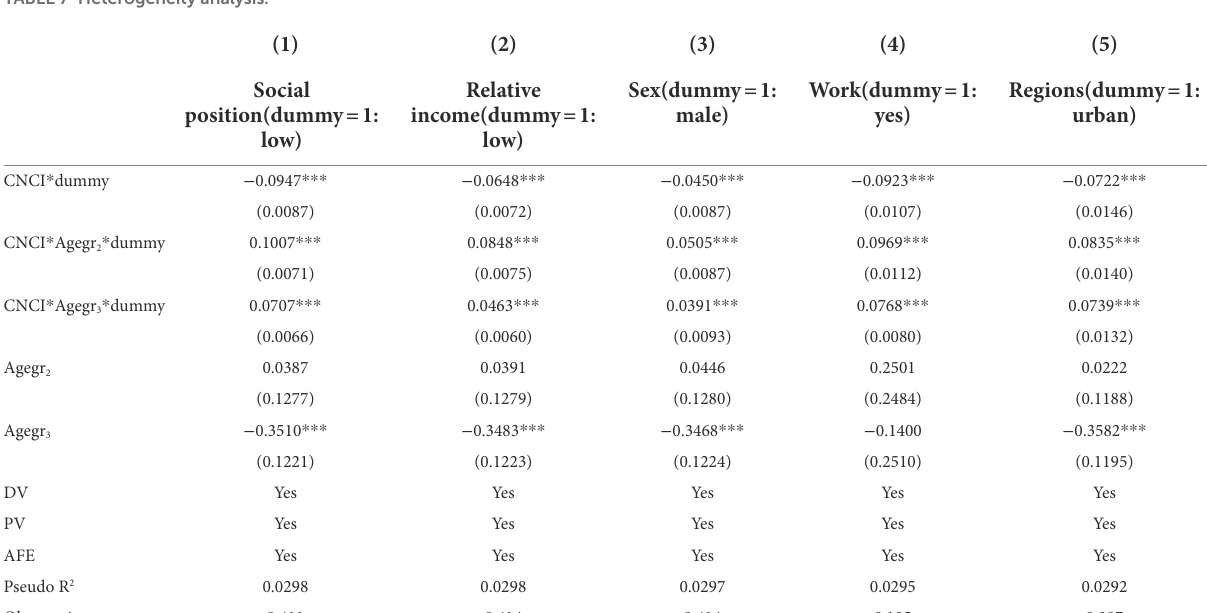
TABLE 7 Heterogeneity